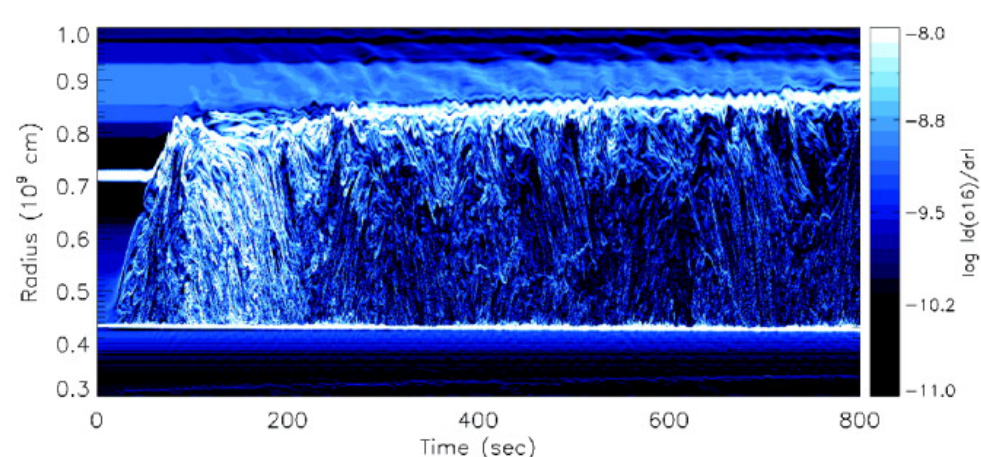
Figure 6. Data are from a hydrodynamical simulation of an oxygen-burning shell; radial coordinate is on the y-axis and time coordinate is on the x-axis. Color shows the radial gradient of the oxygen concentration profile at each time; the thick bright lines denote the top and bottom boundaries of the convective region. Turbulent convection occurs at times t (cid:38) 50, and entrainment causes measurable movement of the convective boundary. Figure 4 of Meakin and Arnett [25]; © AAS. Reproduced with permission.